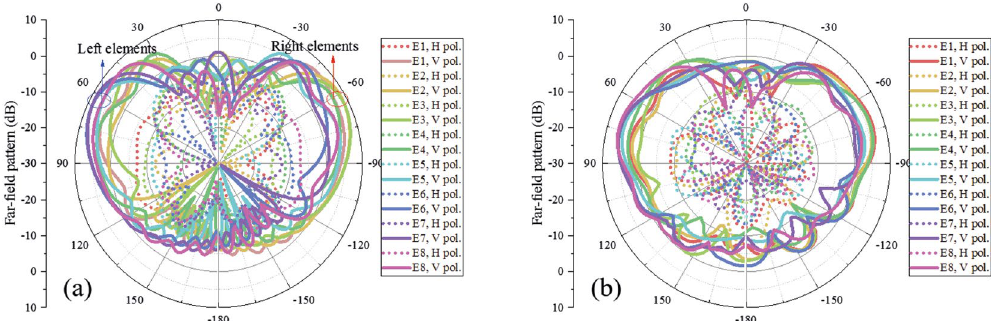
Figure 11. Active far-field radiation patterns of each element in the array. ( a ) Simulated and ( b ) measured active far-field radiation patterns in the yz plane. E1~E8 represent Element 1~Element 9, respectively. The H pol. and V pol. represent the horizontally polarized component and vertically polarized component, respectively. All the elements have bidirectional radiation patterns in both simulated and measured results shown in the figures, and the vertically polarized component is 15 dB stronger than the horizontally polarized